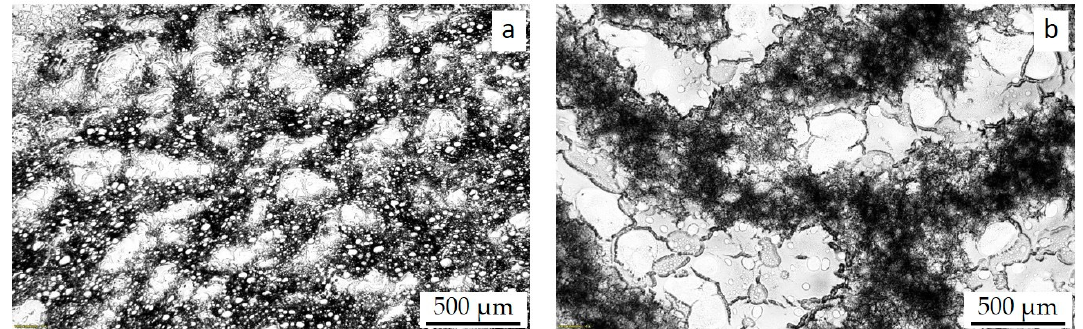
Figure 4. TLM images of PS / PB blends with 1wt % of NC 7000 dispersed in ( a ) toluene and ( b ) chloroform, prepared on glass substrates.